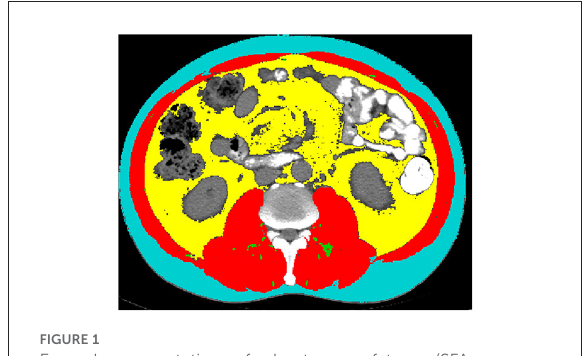
FIGURE1 Example segmentations of subcutaneous fat area (SFA, turquoise), visceral fat area (VFA, yellow), intermuscular fat area (IMFA, green) and skeletal muscle area (SMA, red) at the third lumbar